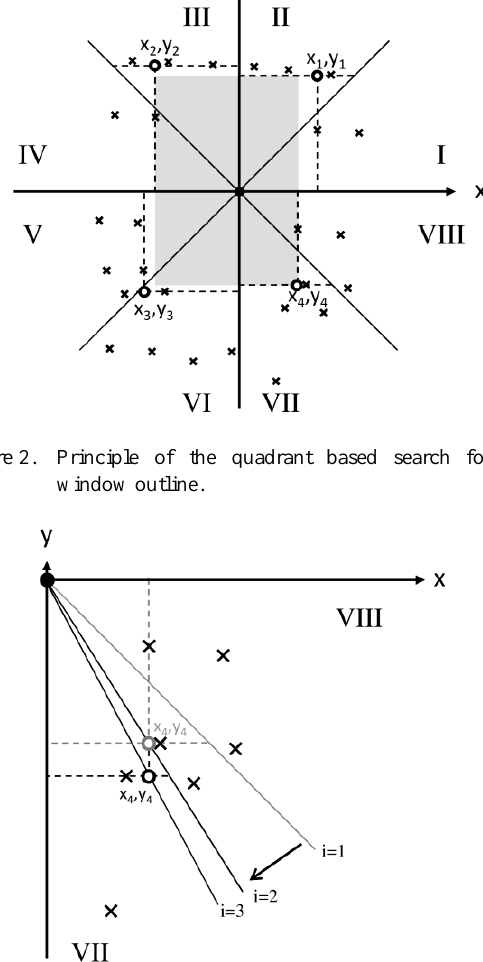
Figure 3. Effect of the iterative procedure during the quadrant